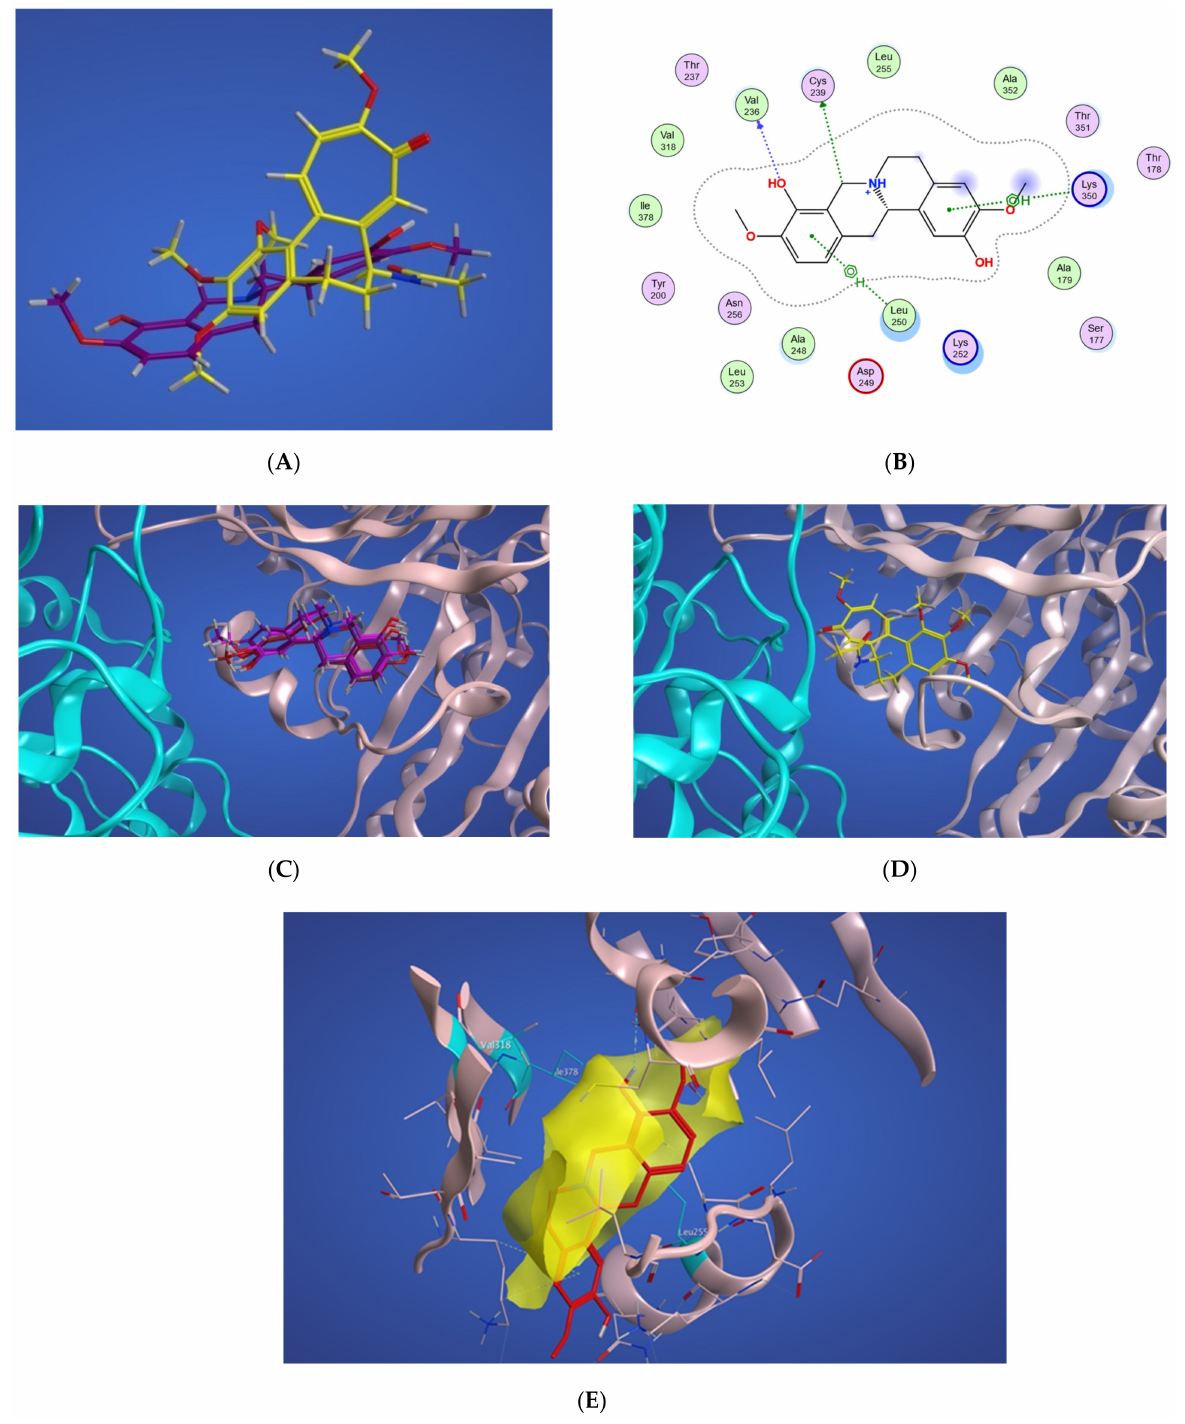
Figure 9. ( A ) Representative structures of scoulerine in cluster B (purple) versus colchicine (yellow). ( B ) Two-dimensional interaction scheme of scoulerine in the colchicine binding site. ( C ) Represen- tative structures of cluster A (red), cluster B (purple), and cluster C (dark pink) in the colchicine binding site, α tubulin colored in teal, and β I tubulin colored in light pink. ( D ) Colchicine (yellow) in the colchicine binding site, α tubulin colored in teal, and β I tubulin colored in light pink. ( E ) Surface patches identifying regions of hydrophobicity (yellow) around scoulerine, residues Leu255, Val318, and Ile378 of β tubulin that are involved in hydrophobic interaction colored in